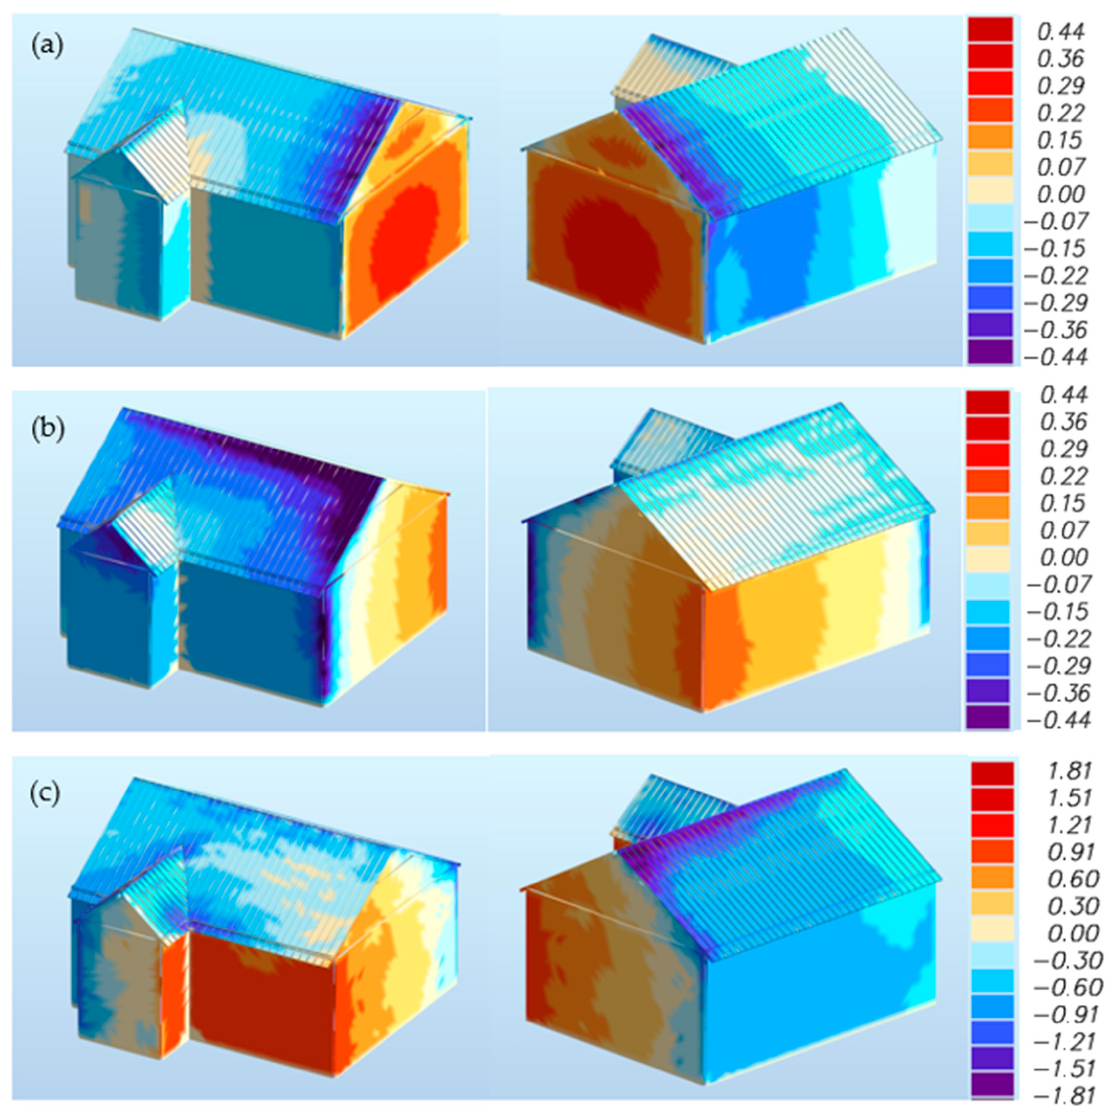
Figure 10. Pressure maps for case LWS, ( a ) for the W1 direction, ( b ) for the W2 direction, ( c ) for the W3 direction.